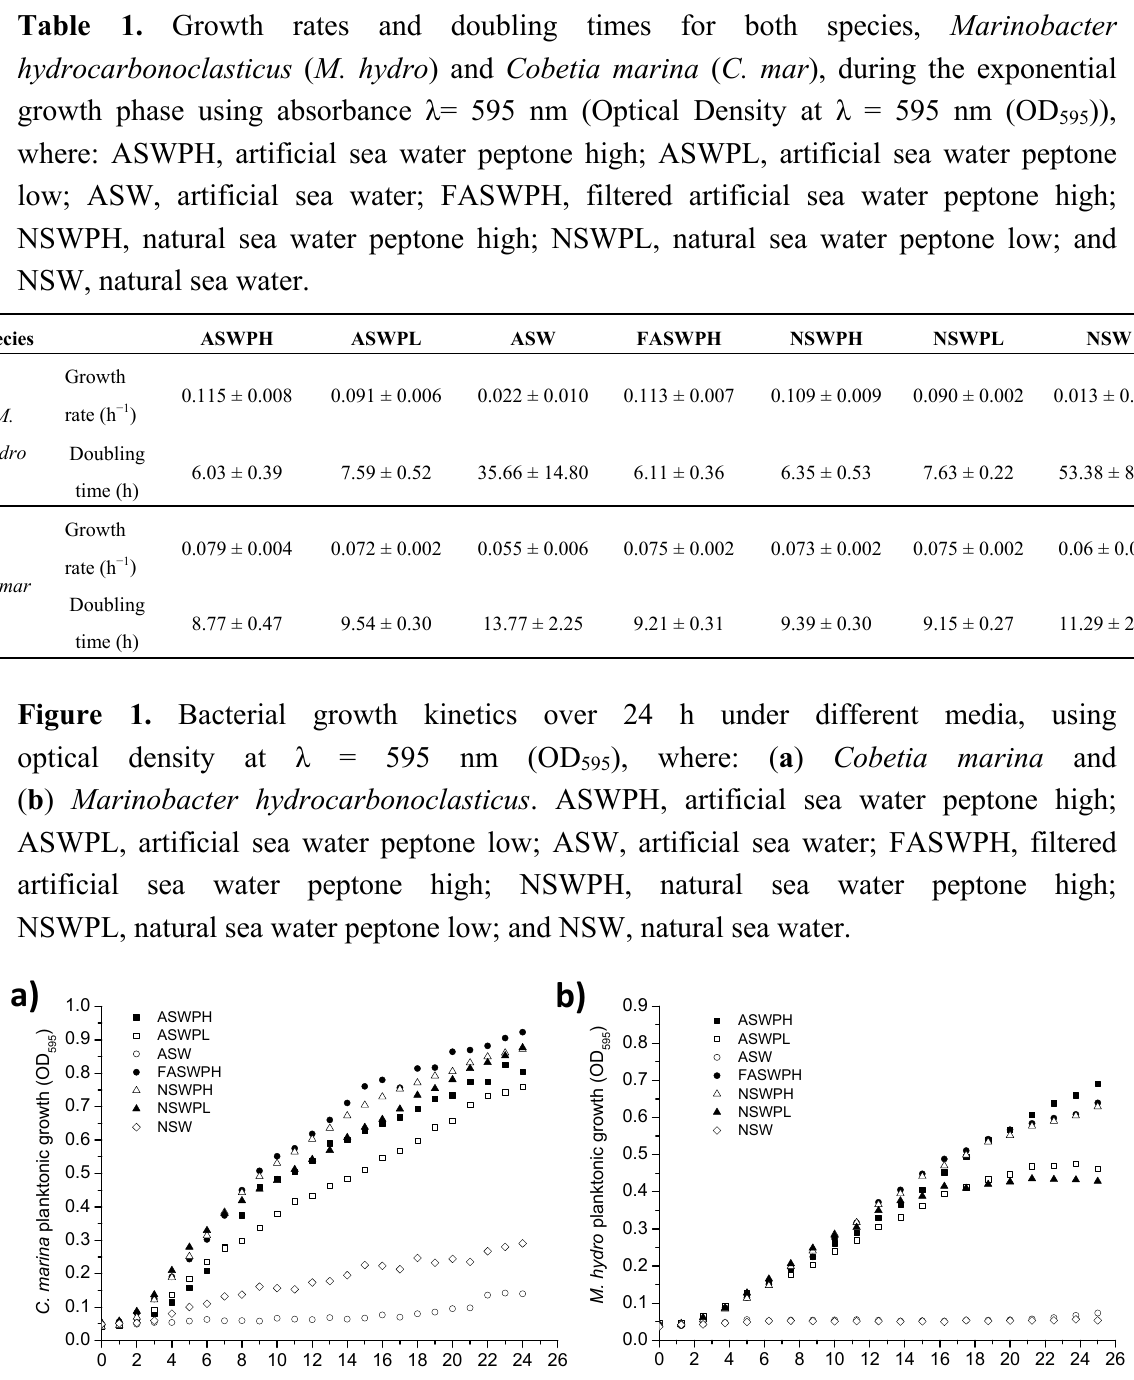
Table 1. Growth rates and doubling times for both species, Marinobacter hydrocarbonoclasticus ( M. hydro ) and Cobetia marina ( C. mar ), during the exponential